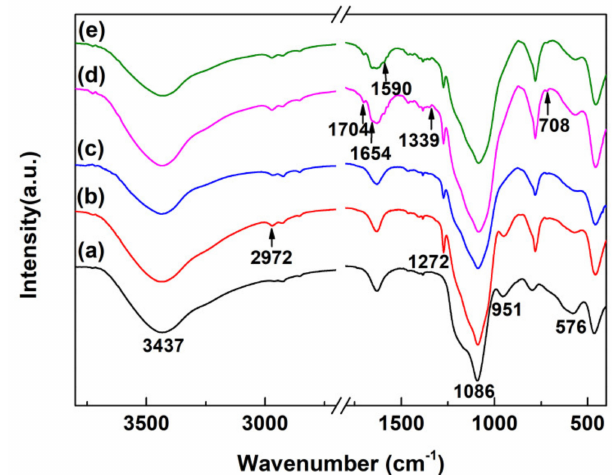
Figure 4. FTIR spectra of ( a ) Fe 3 O 4 @SiO 2 , ( b ) Fe 3 O 4 @SiO 2 -Cl, ( c ) Fe 3 O 4 @SiO 2 -NH 2 , ( d ) Fe 3 O 4 @SiO 2 -Br and ( e ) Fe 3 O 4 @SiO 2 -BPMA